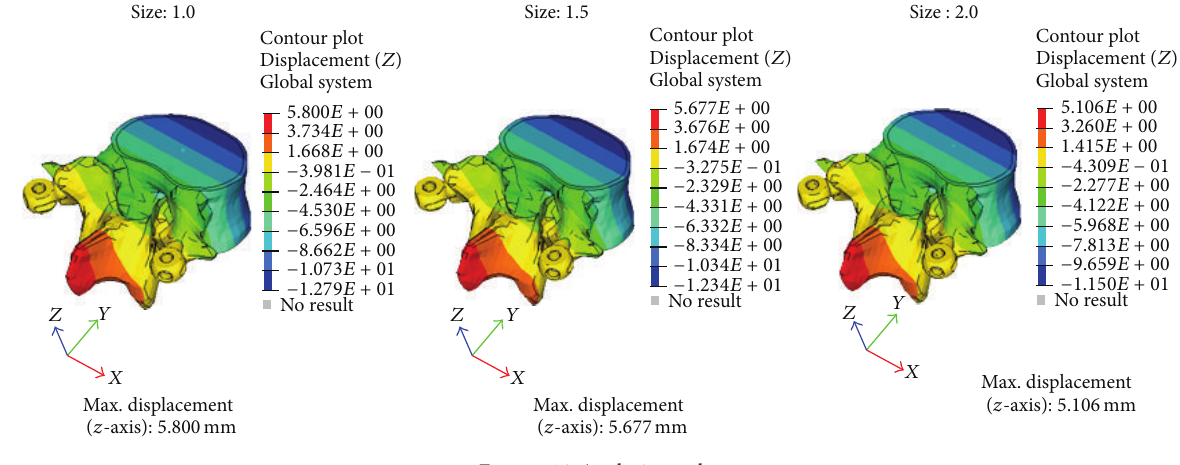
Figure 16: Analysis